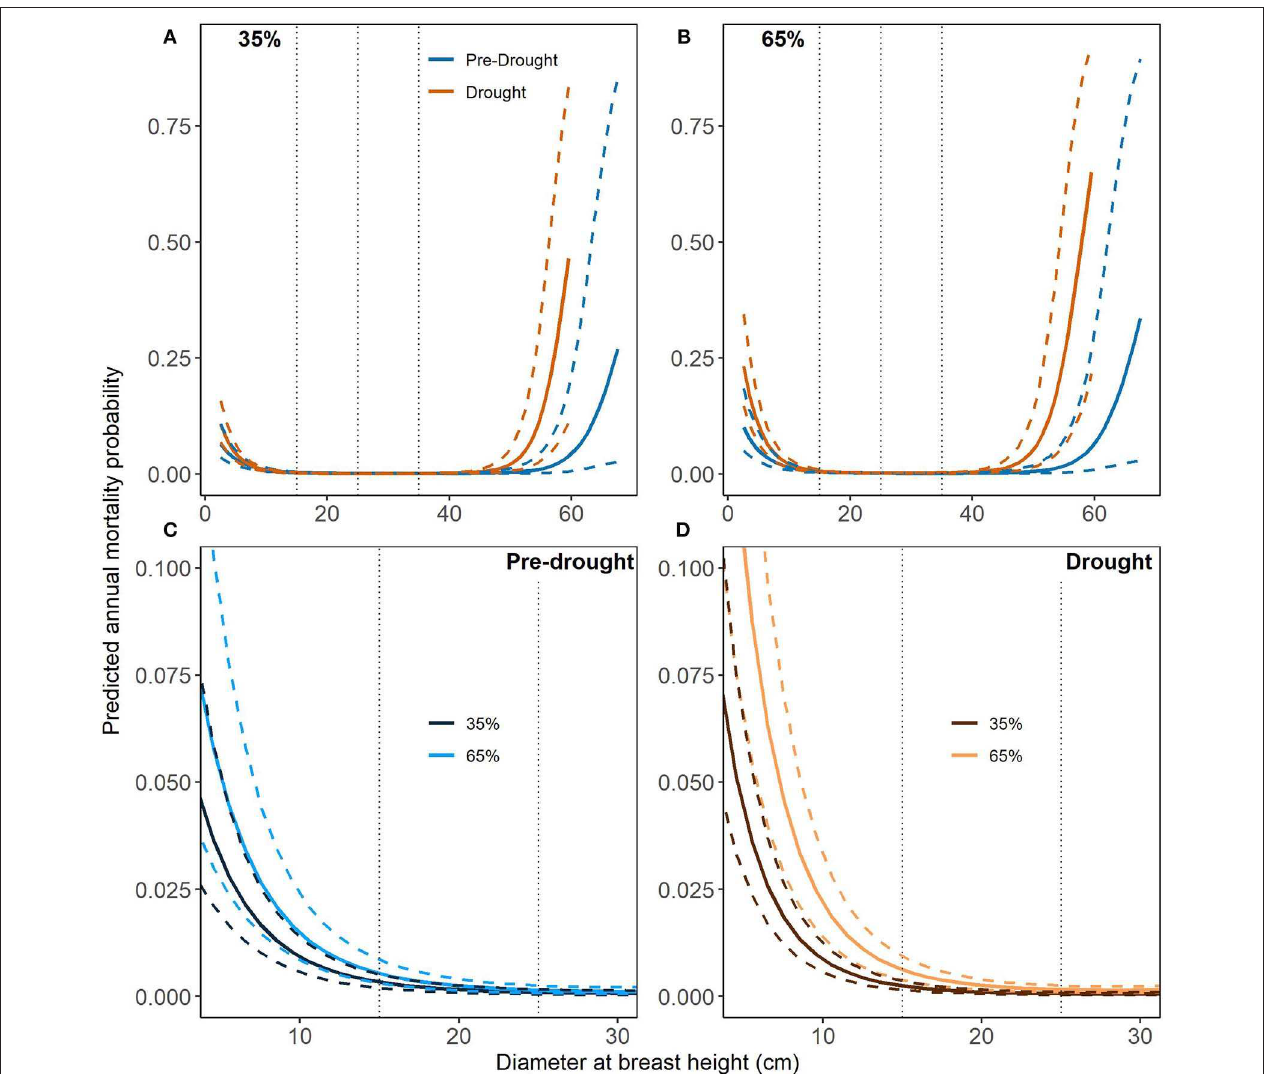
FIGURE 3 | Mortality curves (solid lines) for planted loblolly pine (PL) and diameter at breast height (DBH) with 95% credible intervals (dashed lines). Relative density (RD) is held constant at the lower (35%) and upper (65%) limits of fully-stocked conditions while species dominance (SPD) is held constant at its median values ( ∼ 90%, see Table 1 ). Pre-drought period trees were measured and re-measured from 2003 to 2010 while drought period trees were initially measured prior to 2011 and re-measured 2012–2016. Dotted vertical lines highlight merchantable size classes of 15, 25, and 35cm DBH. (A,B) show mortality curves across the full range of DBH values while (C,D) display notable differences which occur at smaller DBH